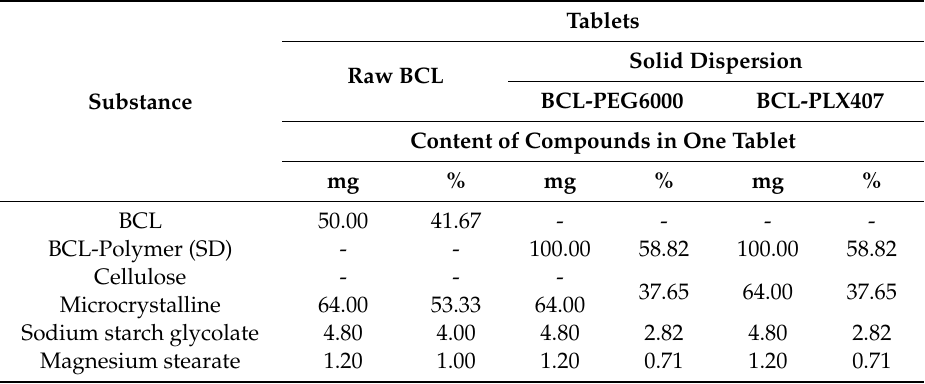
Table 2. The composition of tablets containing BCL-PEG6000 and BCL-PLX407 solid dispersions and raw bicalutamide.